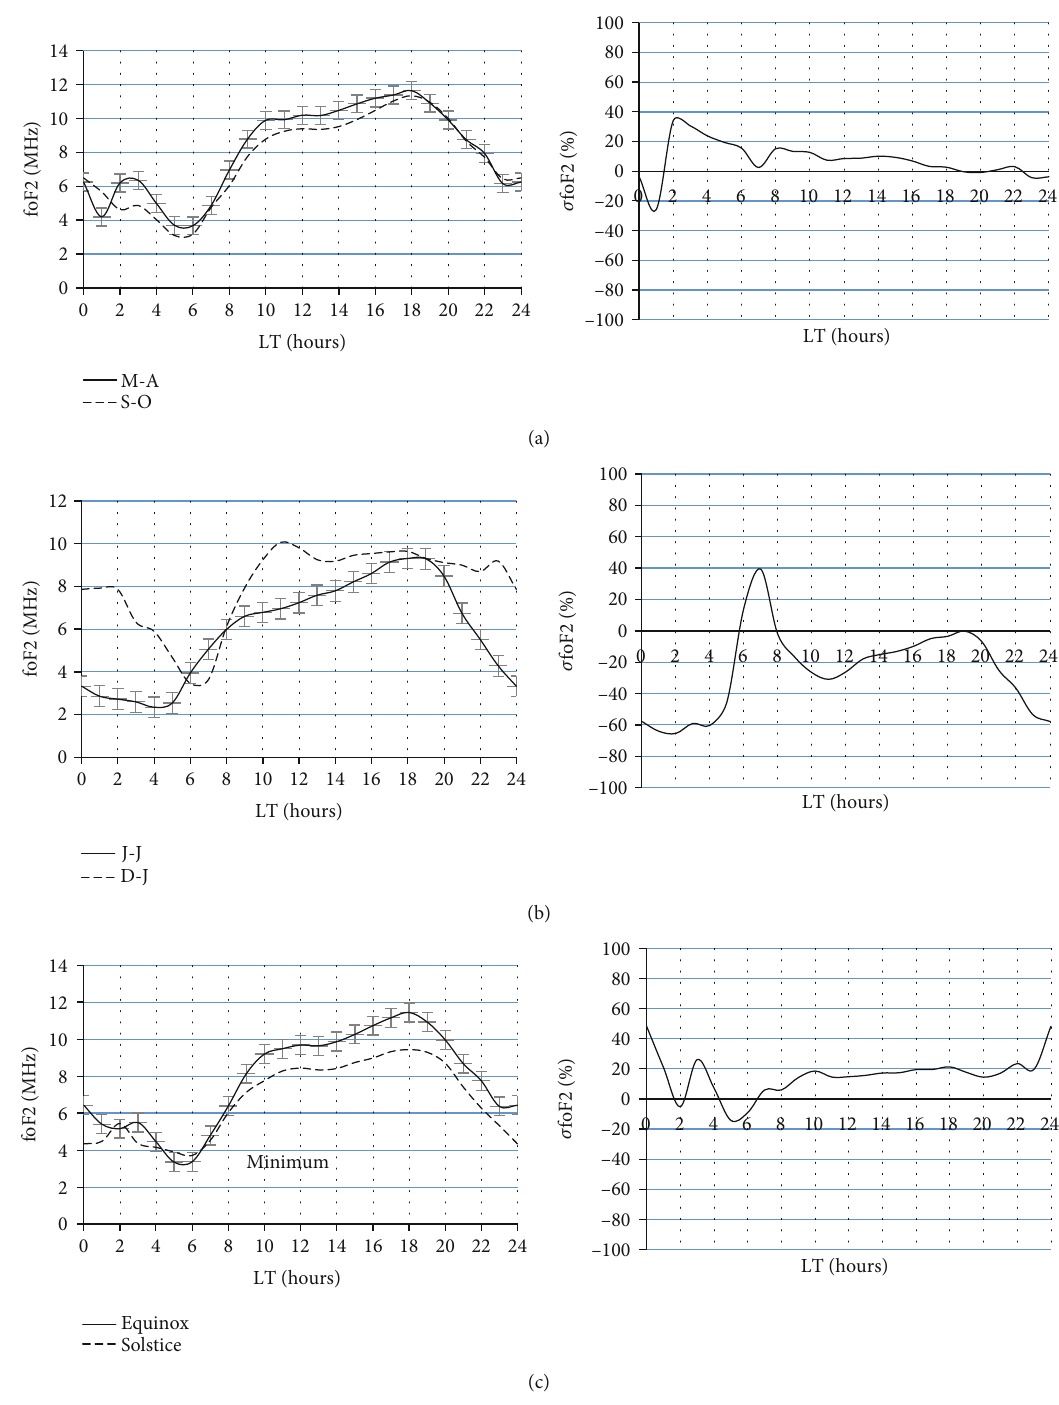
Figure 4: The same as Figure 1 but for the solar cycle decreasing